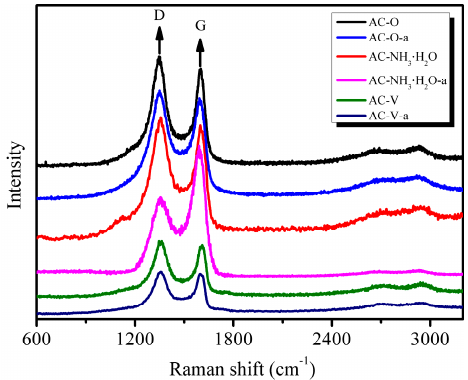
Figure 5. Raman spectra of carbonaceous materials in the region 3200–600 cm − 1 , showing first ‐ and second ‐ order regions of disordered AC.